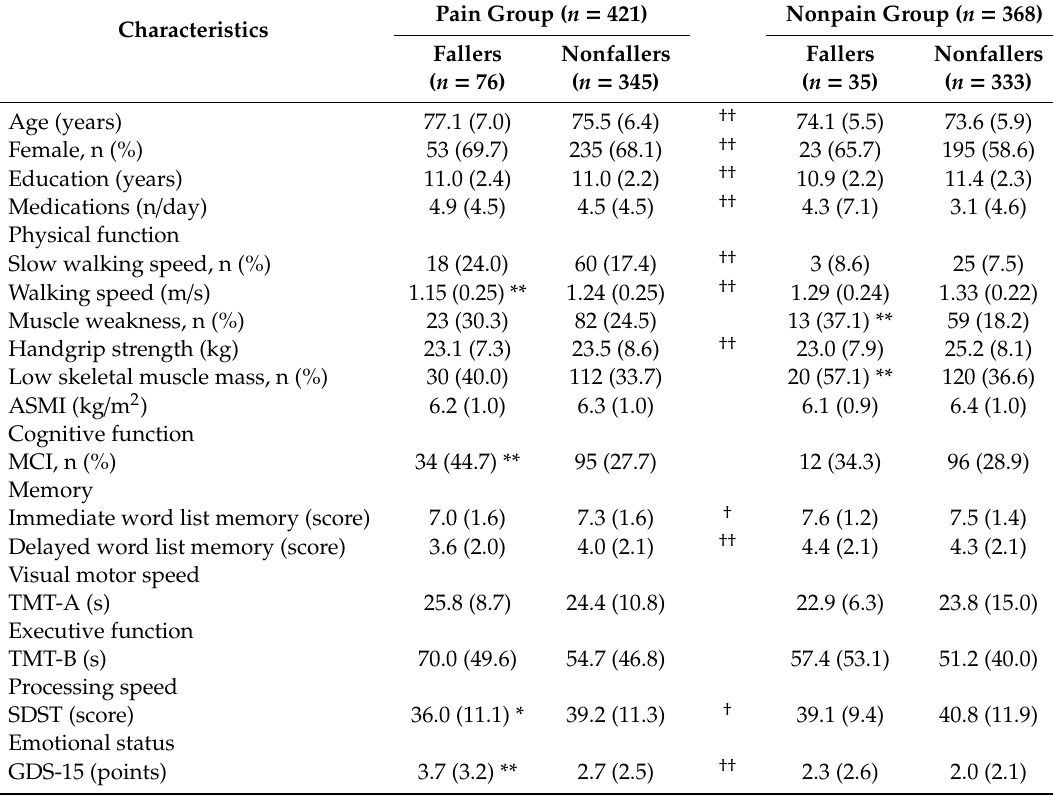
Table 1. Comparisons of physical, cognitive and emotional factors between the fallers and nonfallers in the pain and nonpain